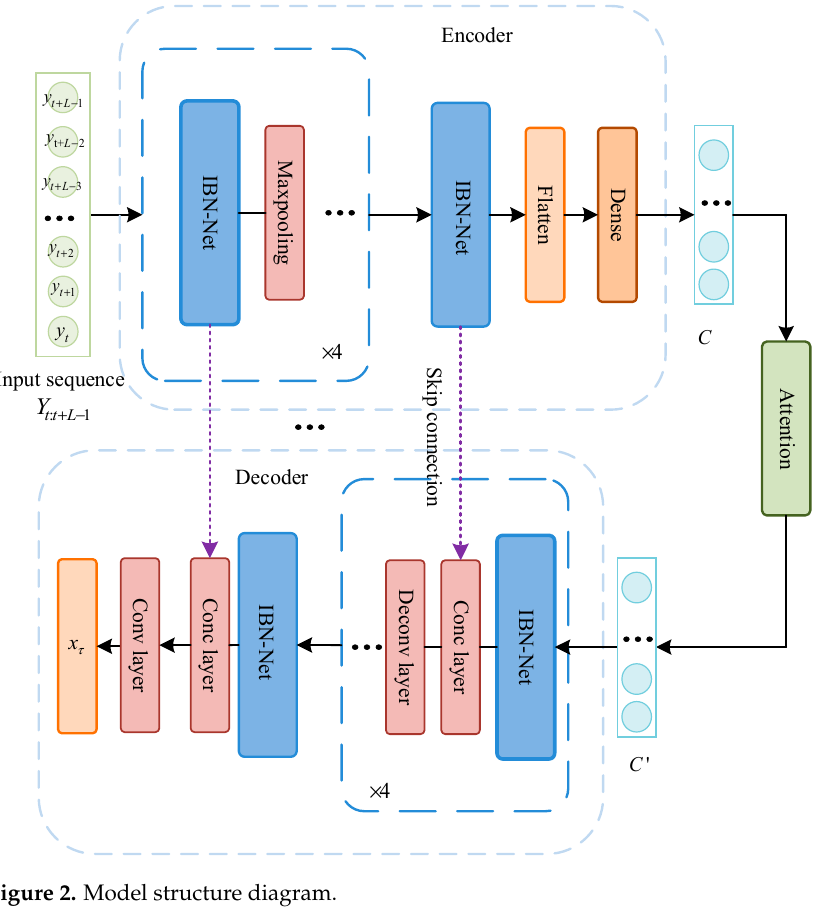
Figure 2. Model structure diagram.